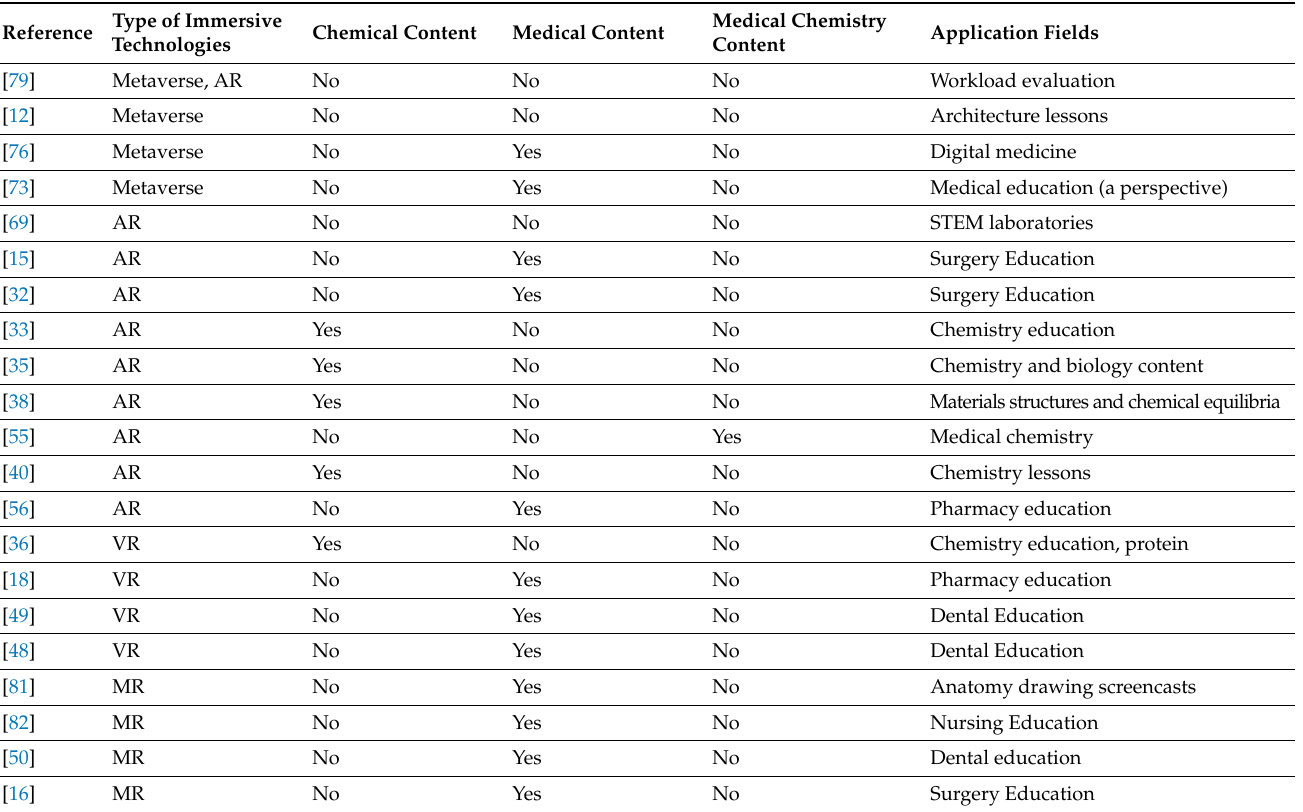
Table 1. Comparison of immersive technologies-based systems in education, particularly chemistry, medical chemistry, and